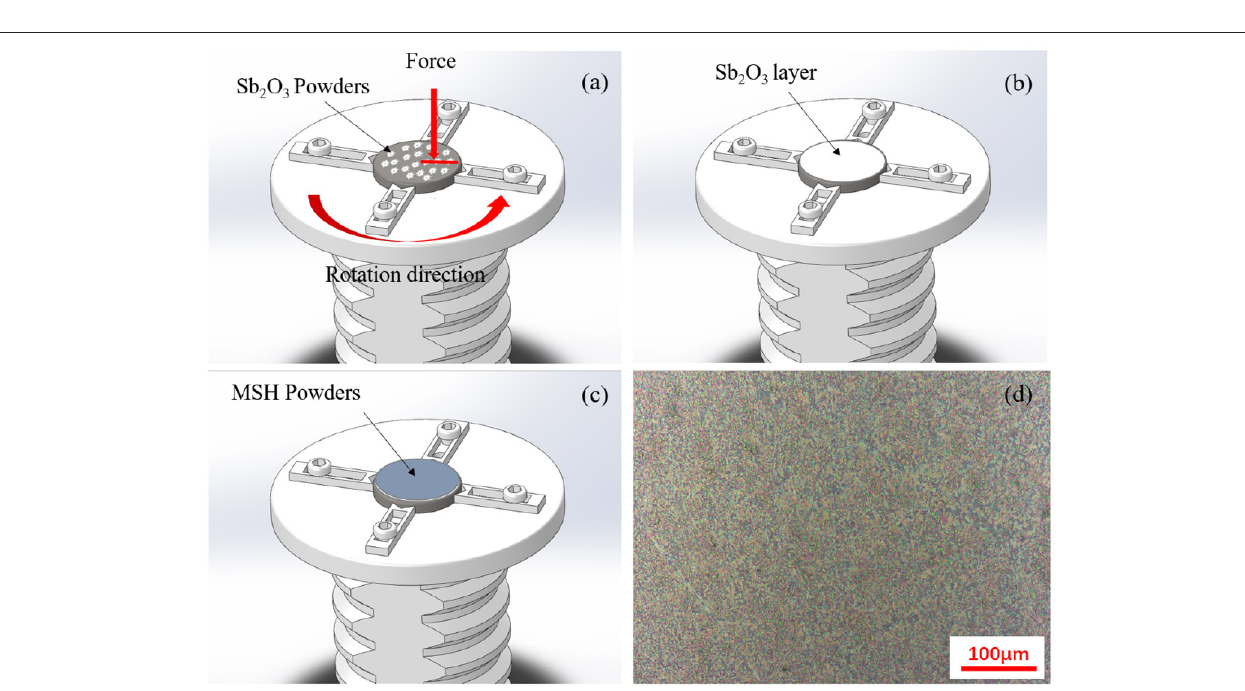
sampling beam size was 2 mm in diameter).